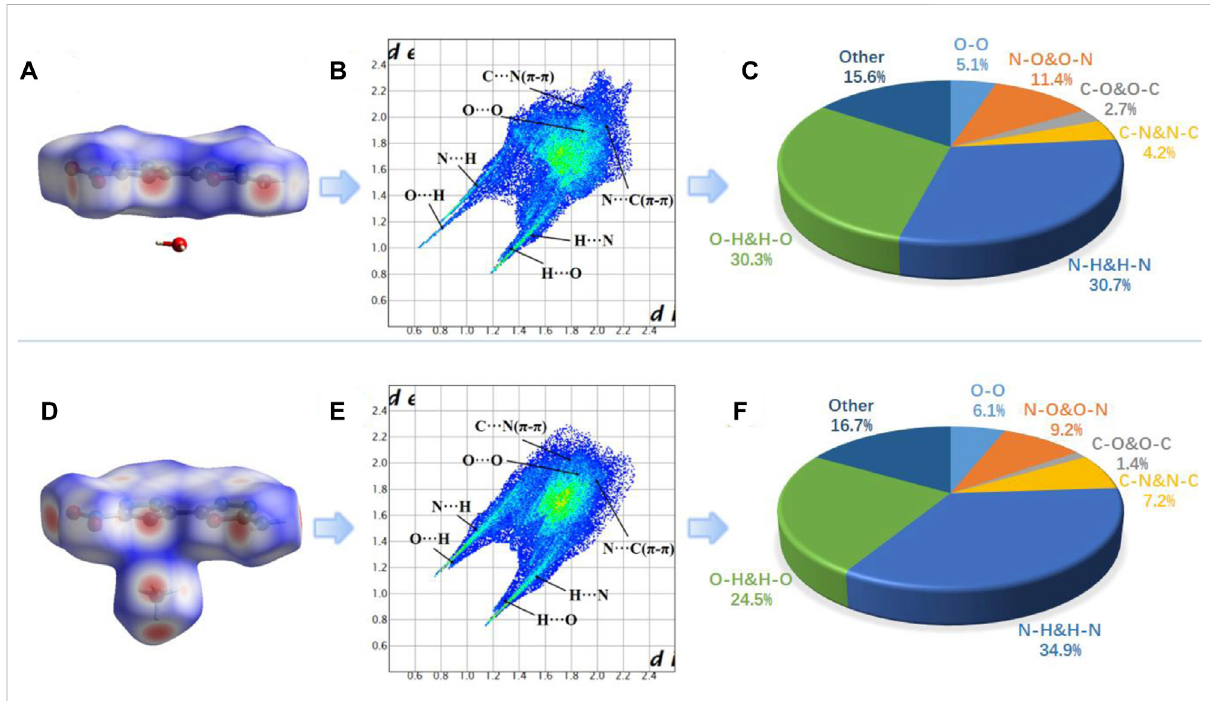
FIGURE 5 (A) , (D) Hirshfeld surface of 8 and 8a; (B), (E) fi ngerprint plot for 8 and 8a; (C), (F) the percentage contribution of every atomic contact for 8 and